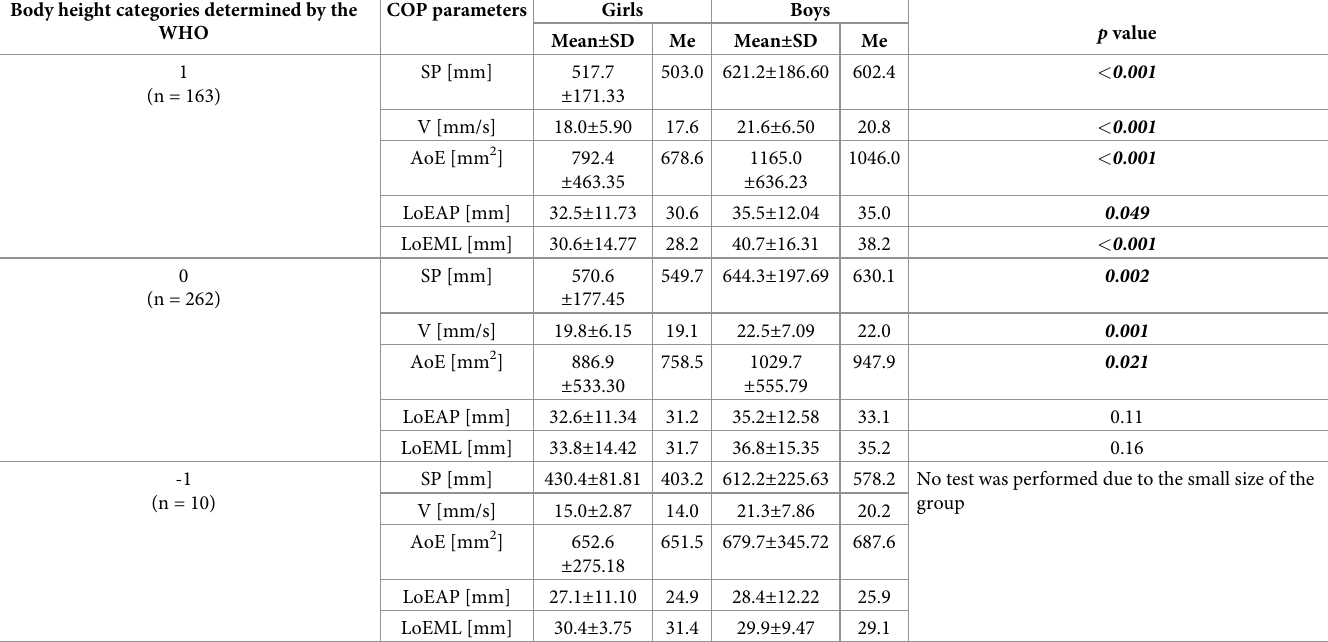
Note: n—number of children; SD–standard deviation; Me–median; SP–sway path length of COP; V–average velocity of COP; AoE–area of the ellipse; LoEAP–length of the ellipse in the anterior-posterior direction; LoEML–length of the ellipse in the medial-lateral direction; (1) tall-statured children; (0) normal-statured children; (-1) low-statured children. Statistical significance was set at p <